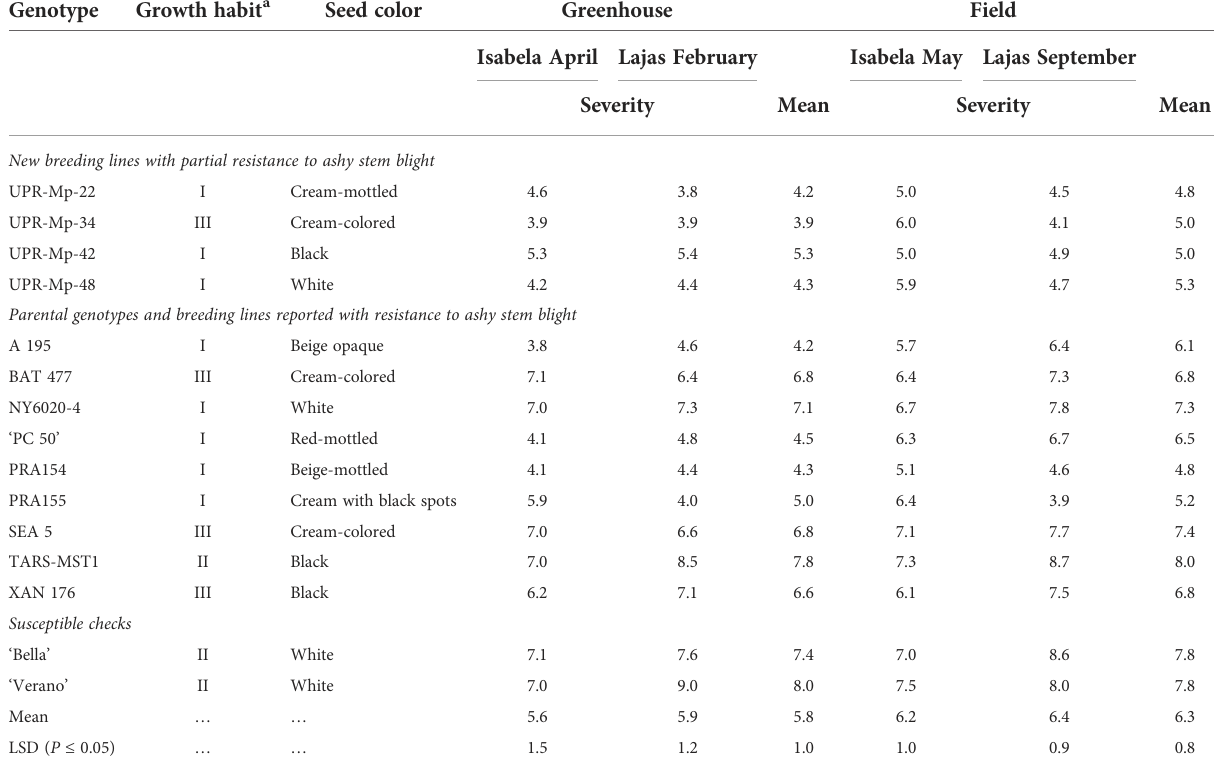
TABLE 3 Growth habit, seed color, and ashy stem blight mean scores for four pyramided common bean ( Phaseolus vulgaris L.) breeding lines, their parents/known sources of resistance, and susceptible checks evaluated against PRI21 Macrophomina phaseolina (Tassi) Goidanich isolate at 42 and 21 days after inoculation in the greenhouse and the fi eld in Isabela and Lajas, Puerto Rico, in 2021.